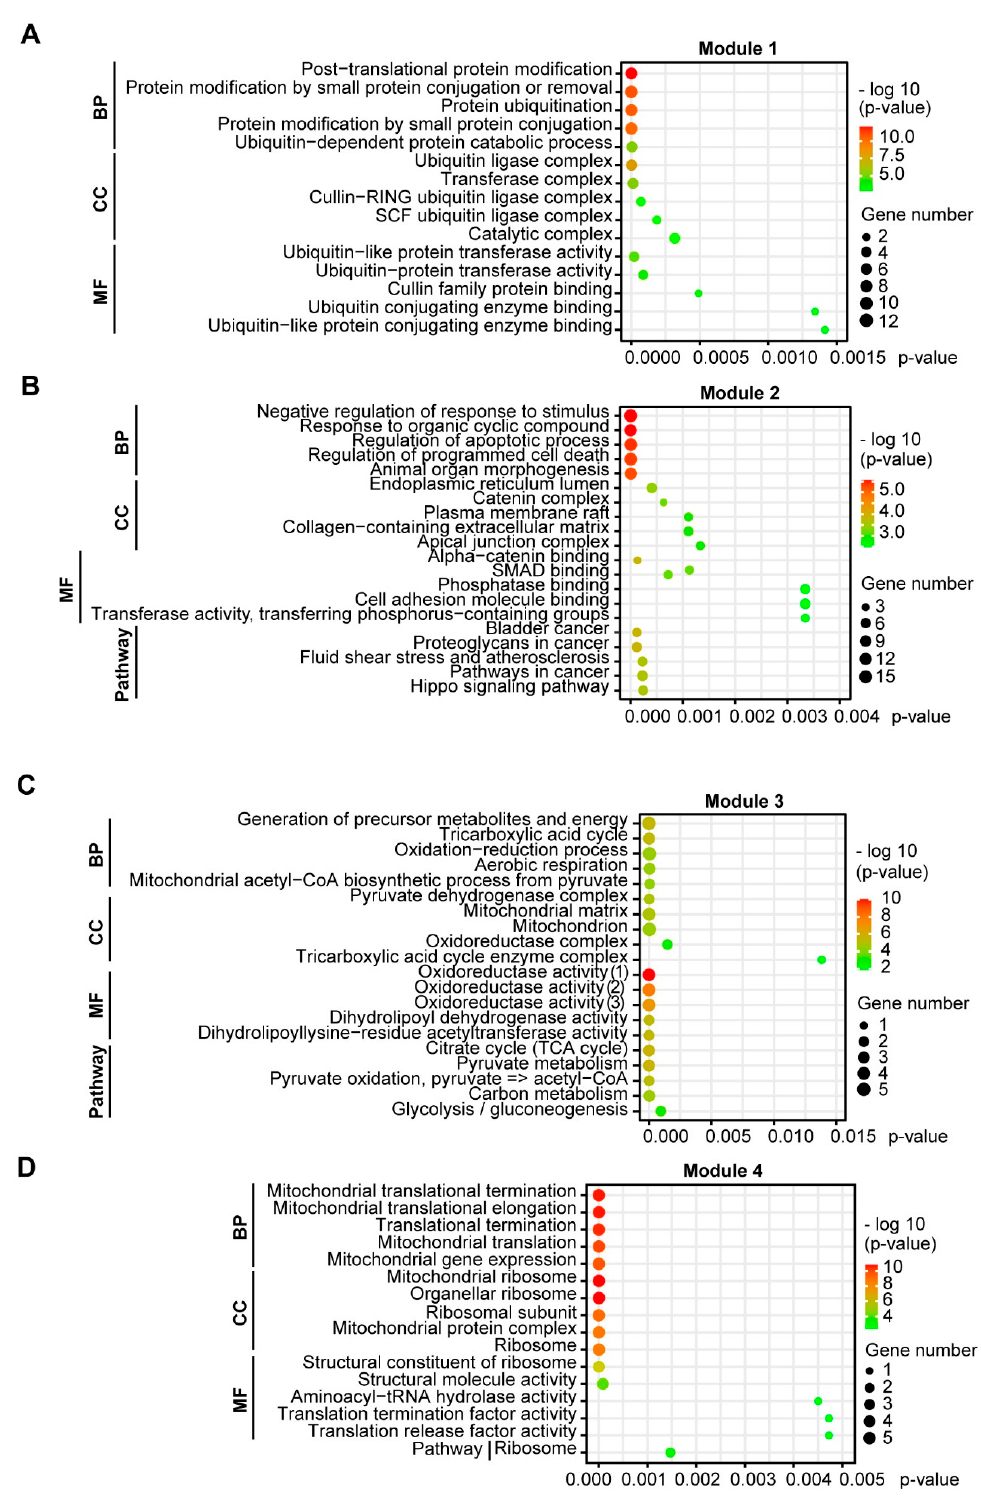
Figure 4. GO functional and KEGG pathway enrichment of clustering module DEGs in EMT of NSCLC cells. Functional enrichment of DEGs was categorized into three groups of GO terms: biological process (BP), cellular component (CC) and molecular function (MF). The significance threshold was set to p < 0.05, corrected by BH FDR. ( A ) Module 1 was involved in protein modification and ubiquitination. ( B ) Module 2 was linked with regulation of programmed cell death and morphogenesis, cell adhesions and pathways in cancer. ( C ) Module 3 was associated with aerobic respiration, the mitochondrial matrix, and pathways in glycolysis, pyruvate metabolism and the TCA cycle. ( D ) Module 4 related to mitochondrial translation and the mitochondrial